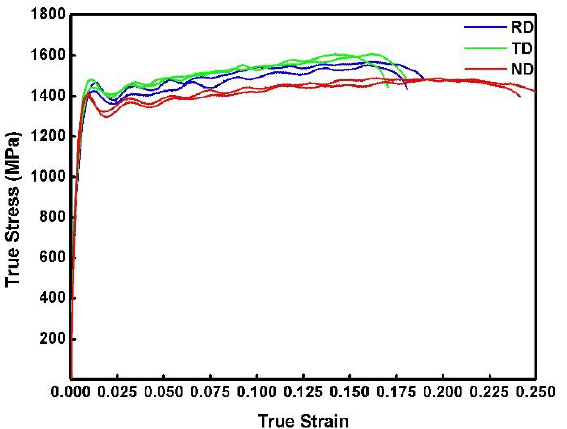
Figure 2. Dynamic compressive stress – strain curves for the mill-annealed Ti-6Al-4V alloy plate that is loaded in the RD, TD and ND. Table 1. Dynamic compressive mechanical performance of TC4 alloy plate.